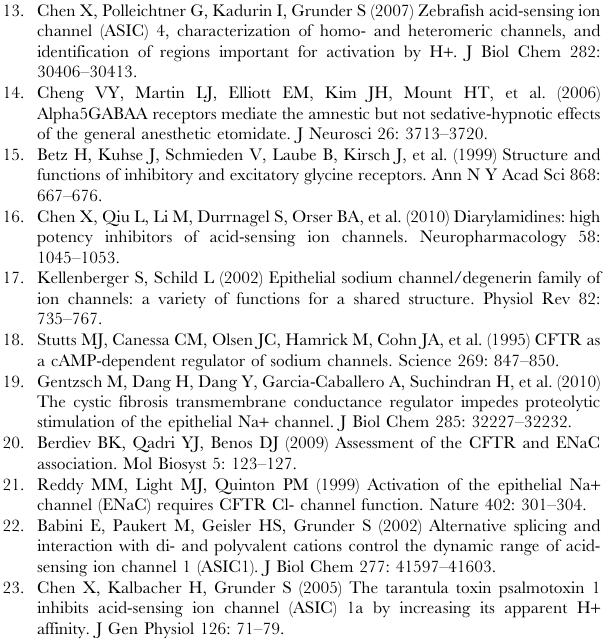
Figure S5 Muscimol modulates ASICs in some recordings (A) but not in other recordings (B) in outside-out patches. A, left, representative traces of ASIC currents in the absence or presence of muscimol; right, bar graph showing the peak amplitude of ASIC currents with or without muscimol. In these outside-out patch recordings (n= 8), muscimol markedly (p , 0.01, paired t -test) decreased the current amplitude of ASICs from 37 6 10 pA to 12 6 5 pA, which were recovered to 33 6 9 pA after washout of muscimol. B, left, representative traces of ASIC currents in the absence or presence of muscimol; right, bar graph showing the peak amplitude of ASIC currents. In these recordings, muscimol did not (p = 0.44, paired t -test) affect the current amplitude of ASICs (n= 10). The current amplitude of ASICs were 44 6 5 pA, 43 6 6 pA and 47 6 6 pA before, during and after muscimol application, respectively. Figure S6 Amiloride and diminazene do not block GABA A receptors. A left, representative traces of GABA-evoked currents